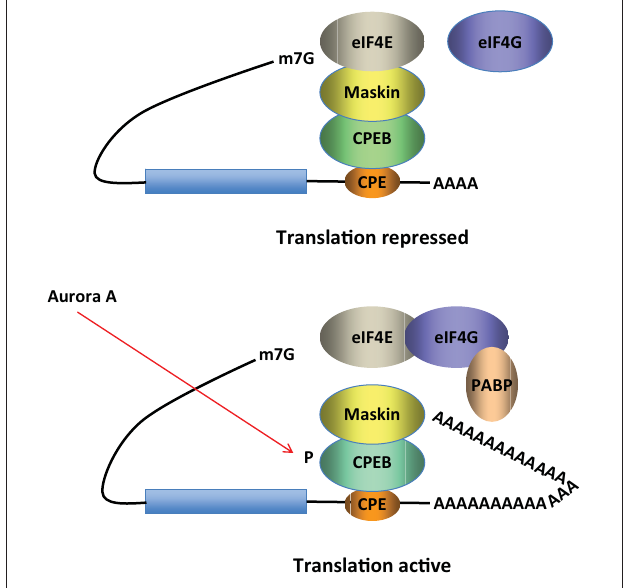
FIGURE 2 | Model for CPEB activity. Some mRNAs contain a cytoplasmic polyadenylation element (CPE), which is bound by CPEB. CPEB also interacts with Maskin (or Neuroguidin, a functionally related protein), which in turn interacts with the cap (m7G) binding protein eIF4E. Such mRNAs are translationally inactive because Maskin inhibits the association of eIF4E and eIF4G, another initiation factor that helps recruit the 40S ribosomal subunit to the 5 ′ end of the mRNA. Cues such as NMDA receptor activation stimulate the kinase Aurora A, which phosphorylates CPEB, an event that causes poly(A) tail elongation. poly(A) binding protein (PABP) binds the newly elongated poly(A) tail and recruits eIF4G. The PABP-eIF4G dimer helps to displace Maskin from eIF4E, allowing eIF4G to bind eIF4E and initiate